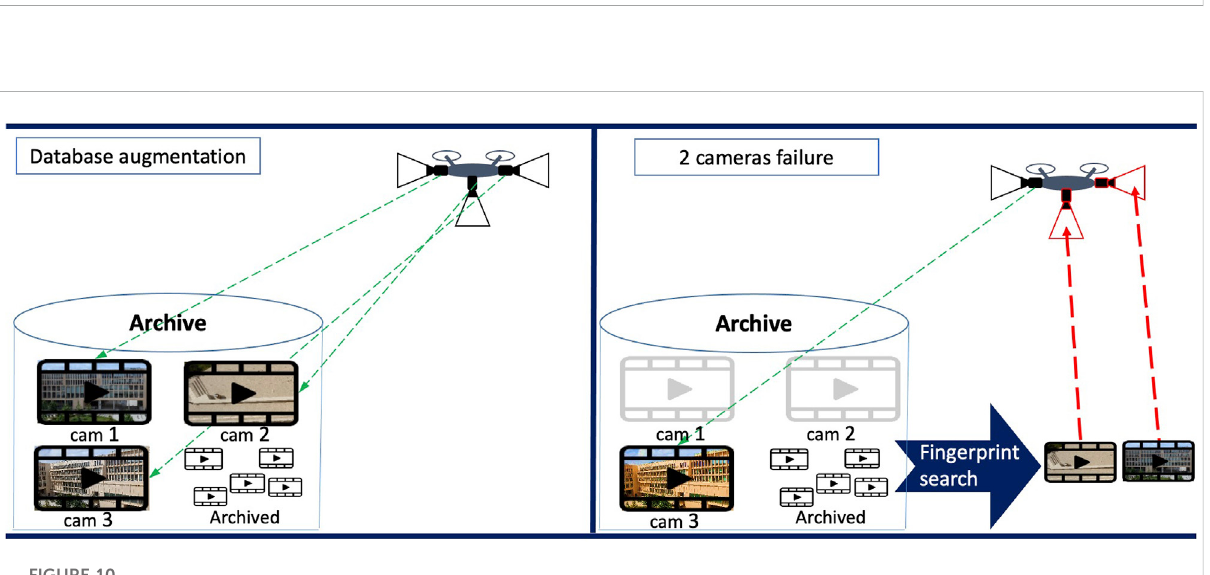
FIGURE 10 Usage of archive video for drone navigation in case of camera